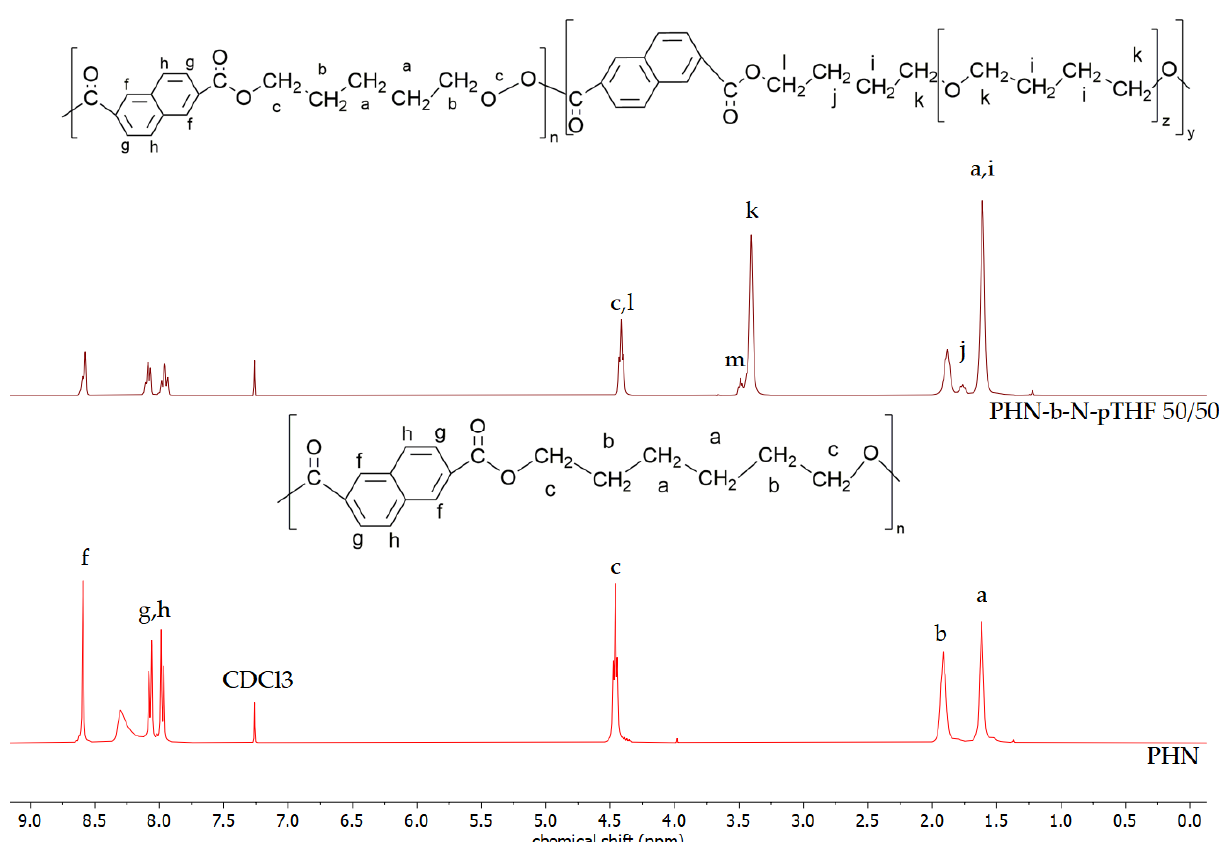
Figure 5. Structure and NMR spectra of PHN and PHN-b-N-pTHF 50/50.